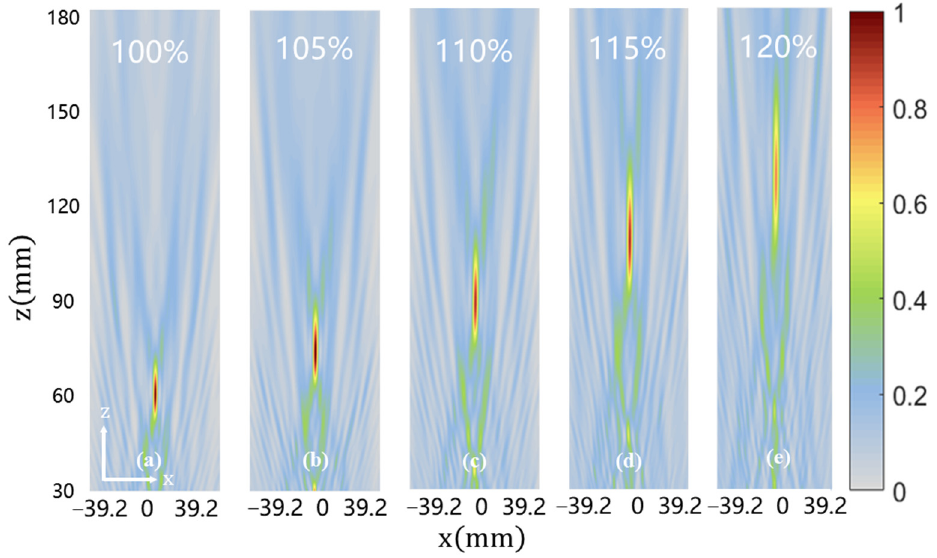
Figure 5. Normalized electric field distribution of the dynamically tunable meta-lens with different stretching factors.